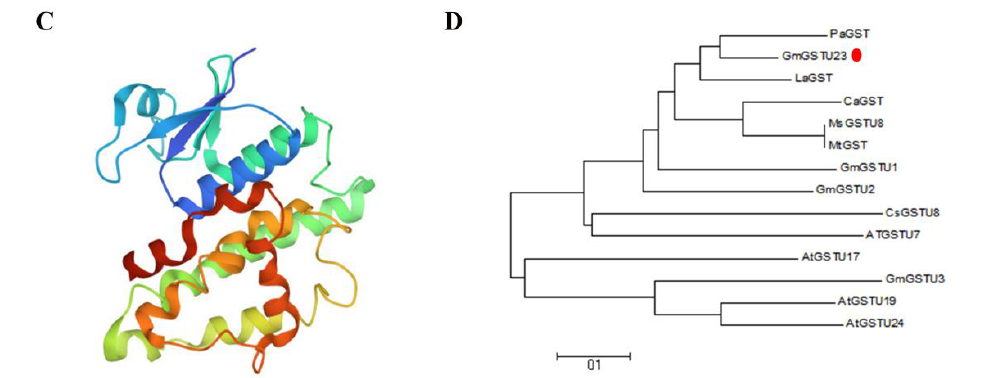
Figure 1. Bioinformatics analysis of GmGSTU23 . ( A ) Conserved domain analysis of the GmGSTU23 protein sequence. ( B ) Sequence comparison of GmGSTU23 and its homologues. GmGSTU23 and its homologs both contain an N-terminal domain (red line) and a C-terminal domain (blue line). ( C ) Prediction of the GmGSTU23 protein structure. The protein structure modeling template is [PDB c6ghfA]. One color represents one protein fold. ( D ) Phylogenetic tree of GmGSTU23 and GST members in other species.